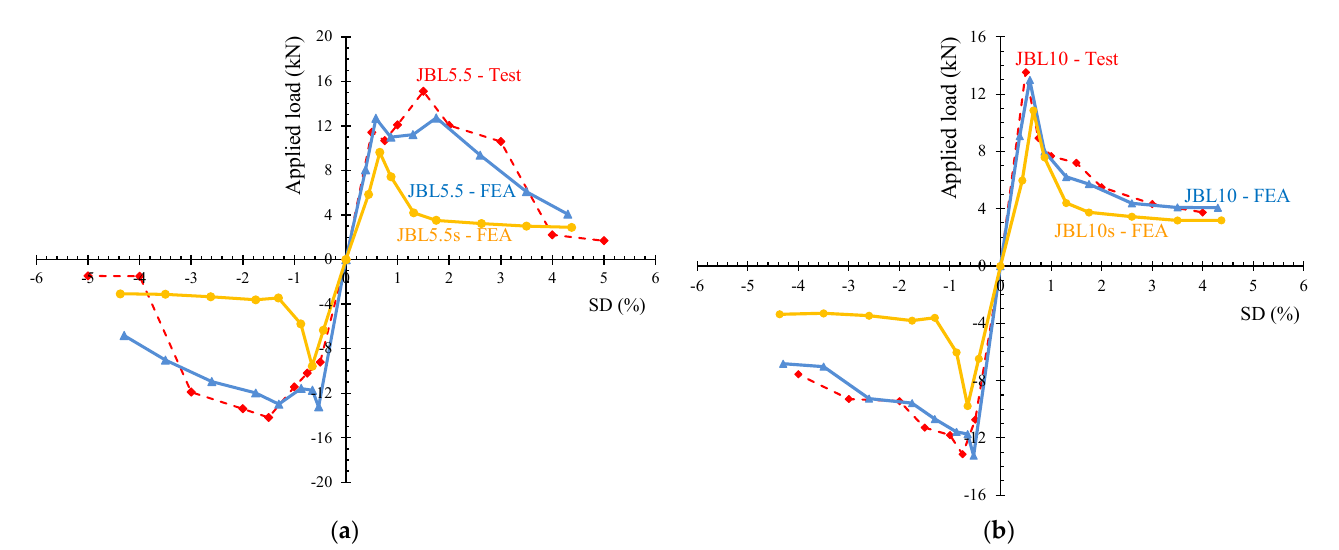
Figure 11. Comparative lateral load versus SD diagrams of the corresponding specimens: ( a ) JBL5.5—Test, JBL5.5—FEA, JBL5.5s—FEA and ( b ) JBL10—Test, JBL10—FEA, JBL10s—FEA. Appl. Sci. 2022 , 12 , x FOR PEER REVIEW